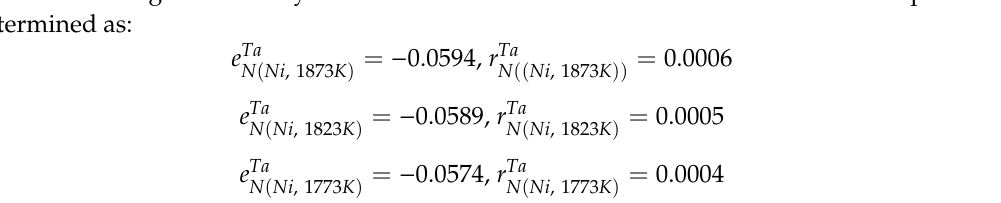
wt pct N p − vs. the tantalum content in binary Ni-Ta alloys at different Figure 9. log ( wt pct N ) − 1/2log p N vs. the tantalum content in binary Ni-Ta alloys at di ff erent Figure 9. ) 1/ 2log N 2 temperatures.